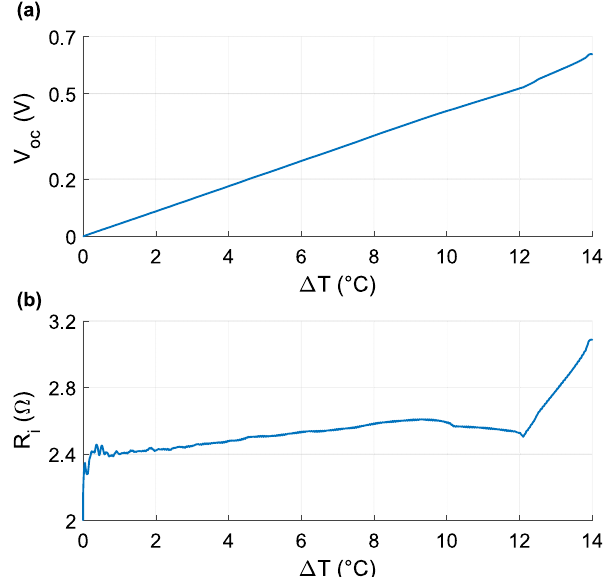
Figure 6. ( a ) Graph of open-circuit voltage V oc according temperature difference ∆ T ; ( b ) graph of internal resistance R i according temperature difference ∆ T .